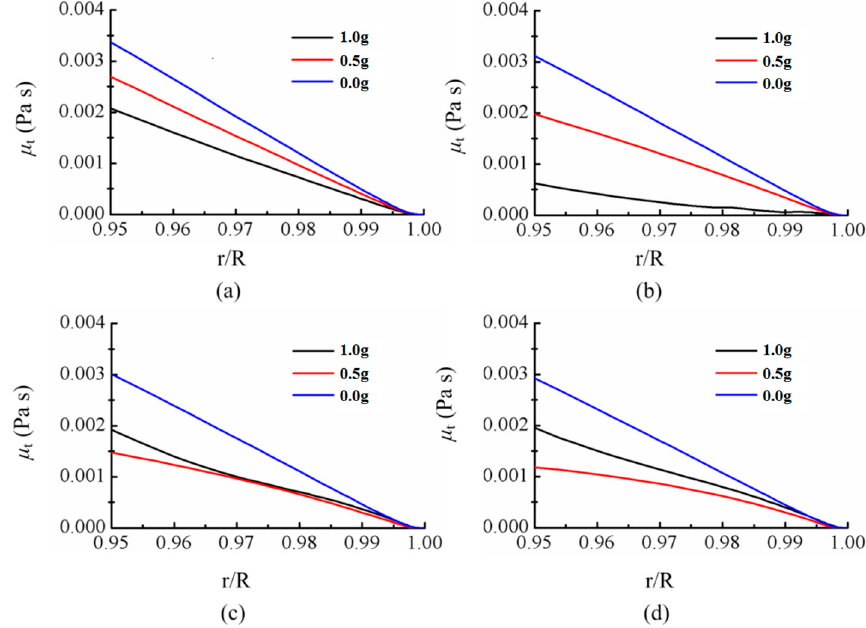
Figure 26. Distribution of the turbulent viscosity in different sections: ( a ) x/D = 13; ( b ) x/D = 26; ( c ) x/D = 39; ( d ) x/D = 53 .